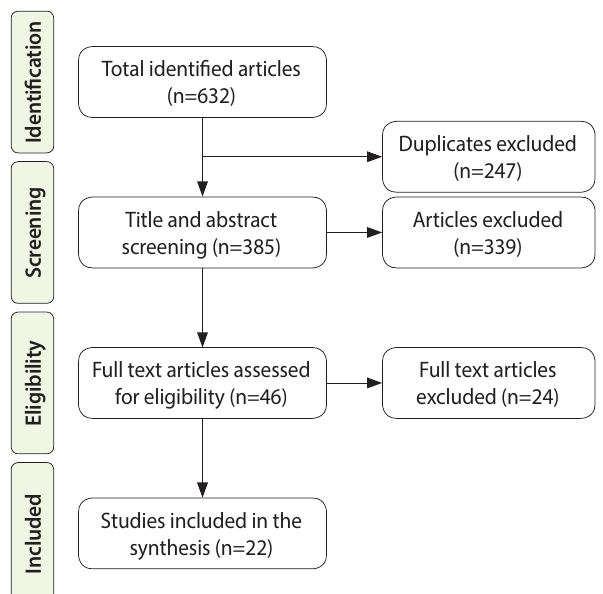
Figure 1. PRISMA (Preferred Reporting Items for Systematic Re- views and Meta-analysis) flow chart of search and